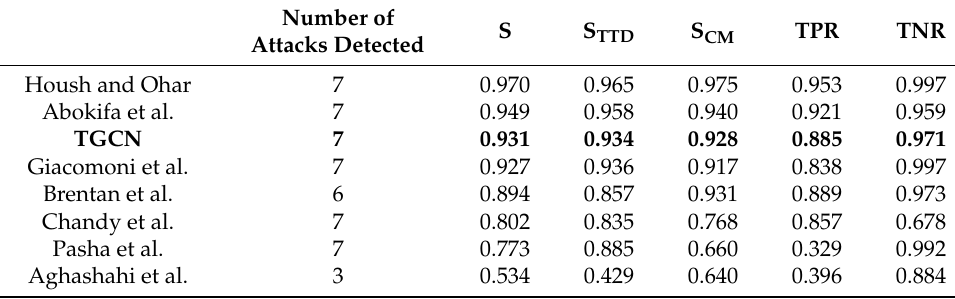
Table 4. Comparison of TGCN with BATADAL